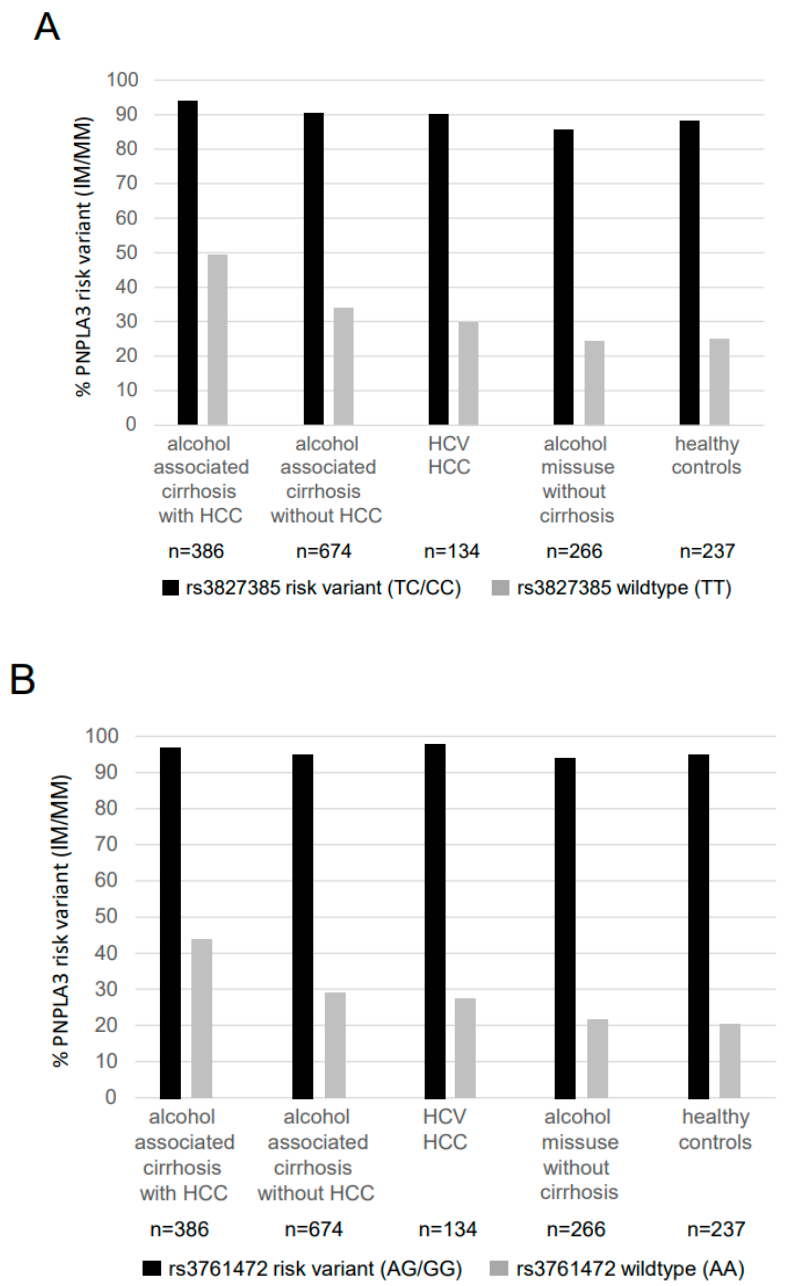
Figure 2. Proportion of patients carrying a SAMM50 risk variant also carrying a PNPLA3 148M risk allele. This figure illustrates that the vast majority of patients carrying a SAMM50 risk variant